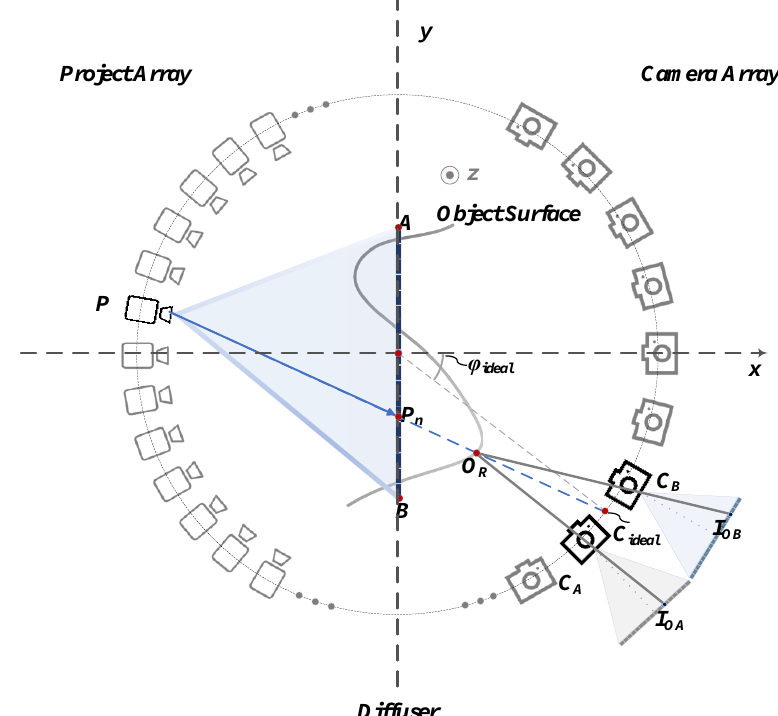
Figure 3. The two nearest cameras and the imaging pixels of R O .